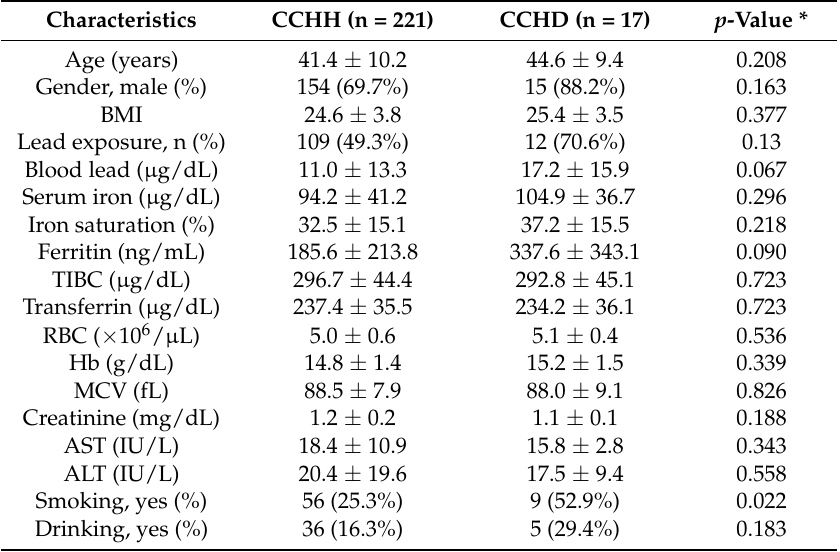
Table 2. Comparison between the CCHH and CCHD